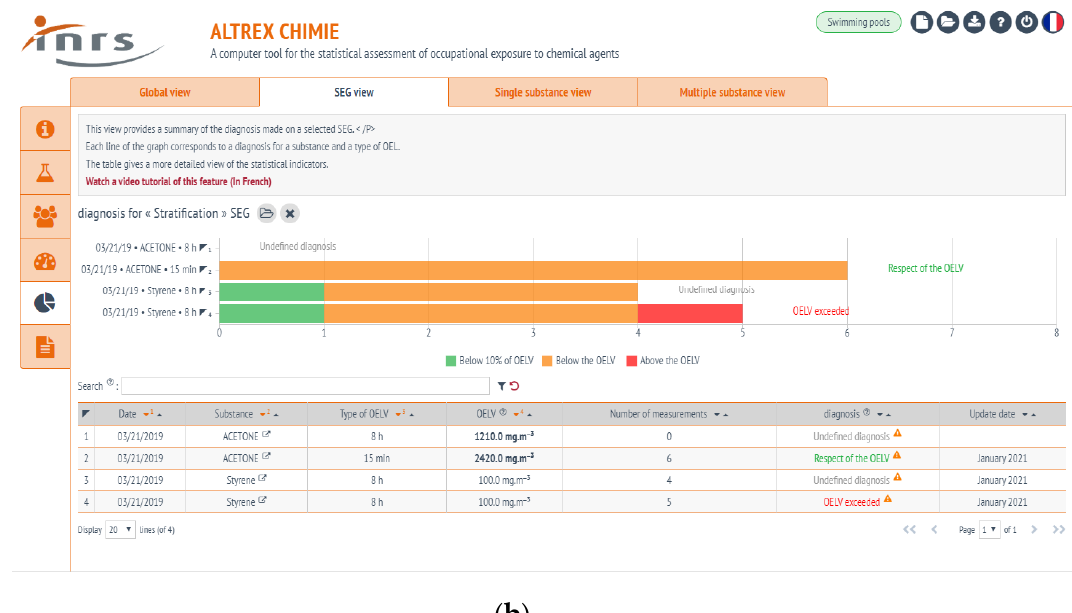
Figure 1. The dashboard shown in the upper part of the figure ( a ) presents a synthesis of all available diagnostics for the enterprise. In this example, one diagnostic exceeds the OELV, two are in compliance, and no conclusion can be made for the others. On the lower part of the figure ( b ), a synthesis of all diagnostics made for a similar exposure group (SEG) is